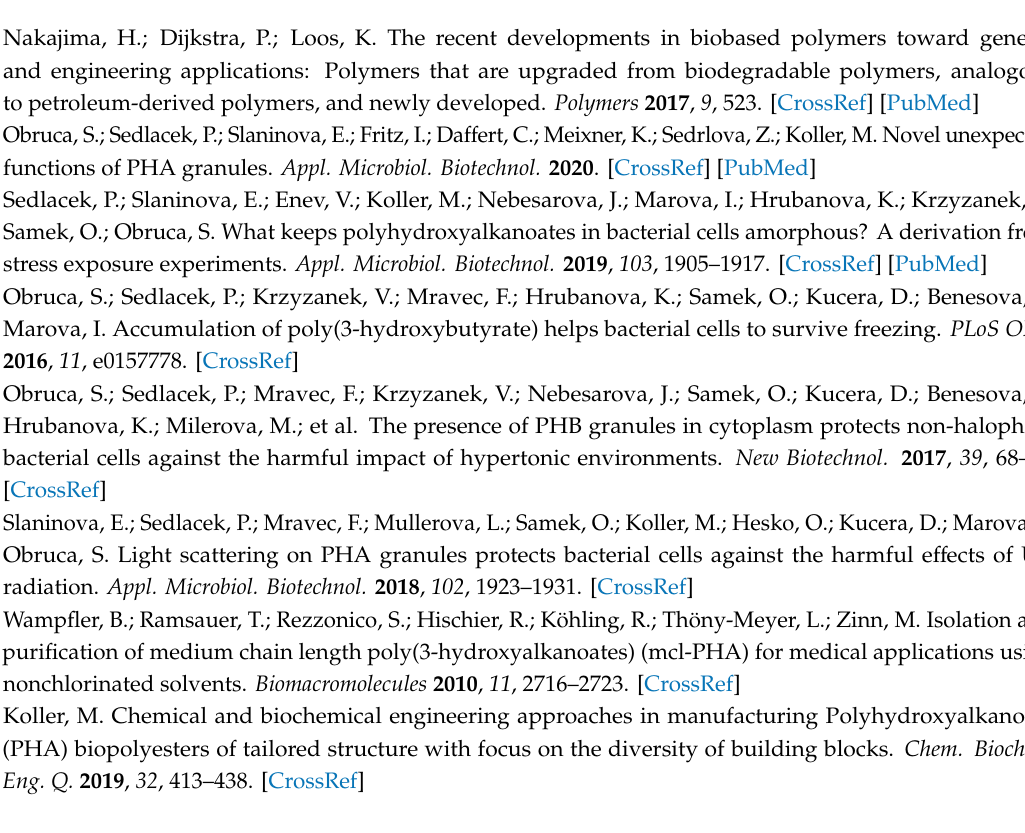
Figure S1: Visual appearance of the PHA films investigated in this study. Figure S2: Complete FTIR spectra of the solution-casted PHA films prepared from polymers with di ff erent monomer composition (each spectrum represents an arithmetic average of 10 individual spectra collected at di ff erent locations on a surface of the film). Figure S3: SEM micrographs of PHA copolymer films before and after the enzymatic degradation assay (magnification 1000 × , scalebar: 100 µ